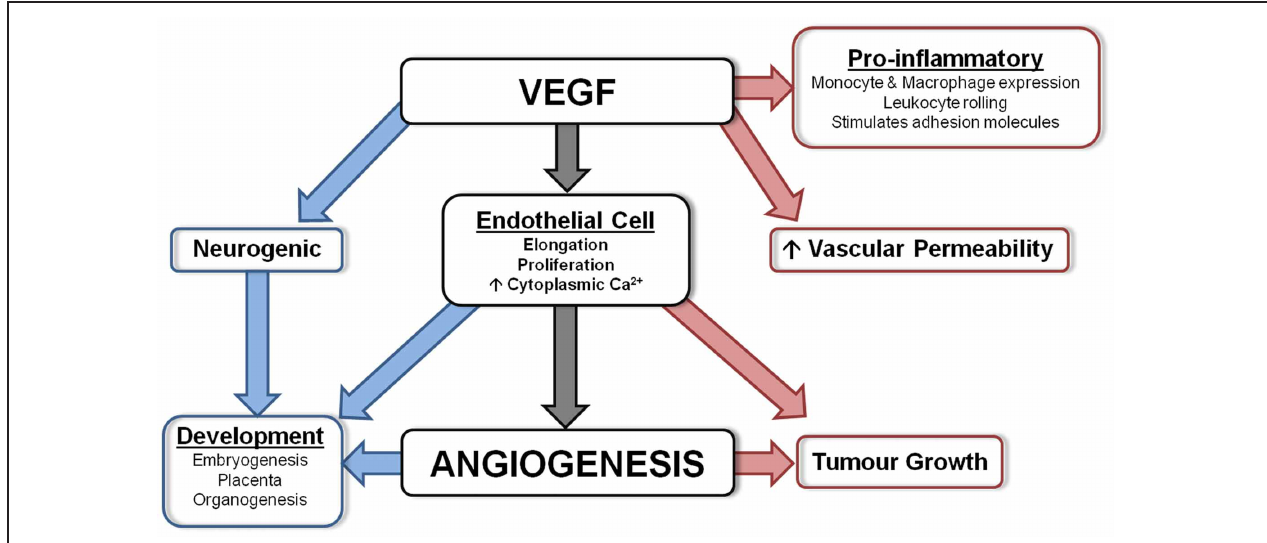
FIGURE 1 | Diagram summarizing the actions of VEGF. VEGF is involved in numerous important physiological processes. Angiogenesis is the main function of VEGF, however, it also has protective actions (shown in blue) which